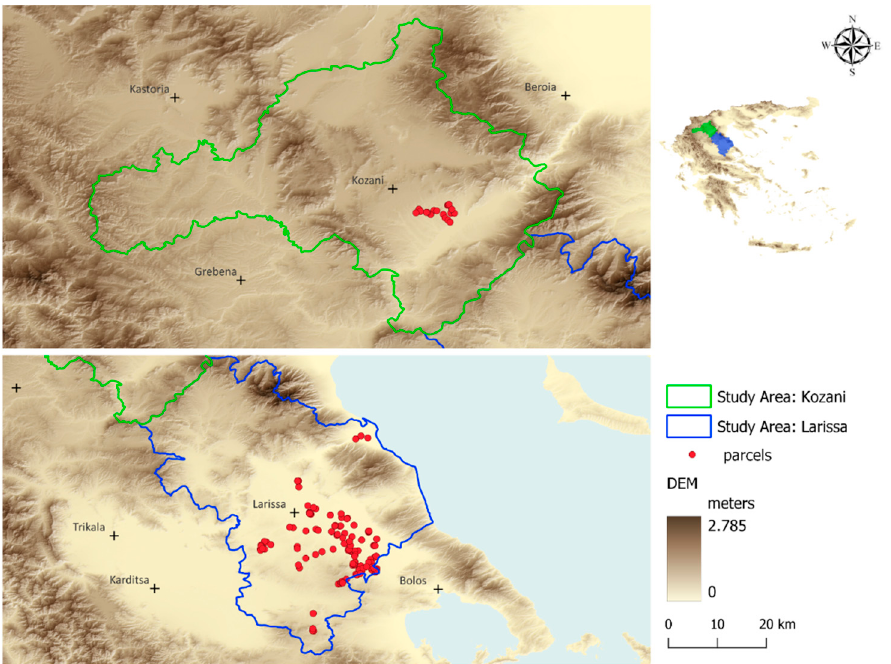
Figure 1. Study areas and parcels.